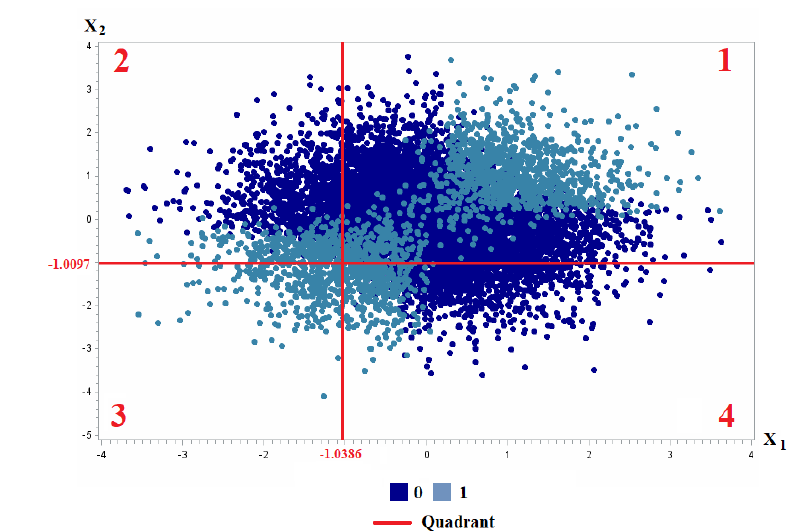
Figure 1. Representation of 10,000 simulations of the logistic model in Equation (12) with an isolated interaction term between X 1 and X 2 . The red axes correspond to the classification tree cut-off points resulting from the discretization of both variables (see Figure 2). The resulting quadrants are also enumerated in